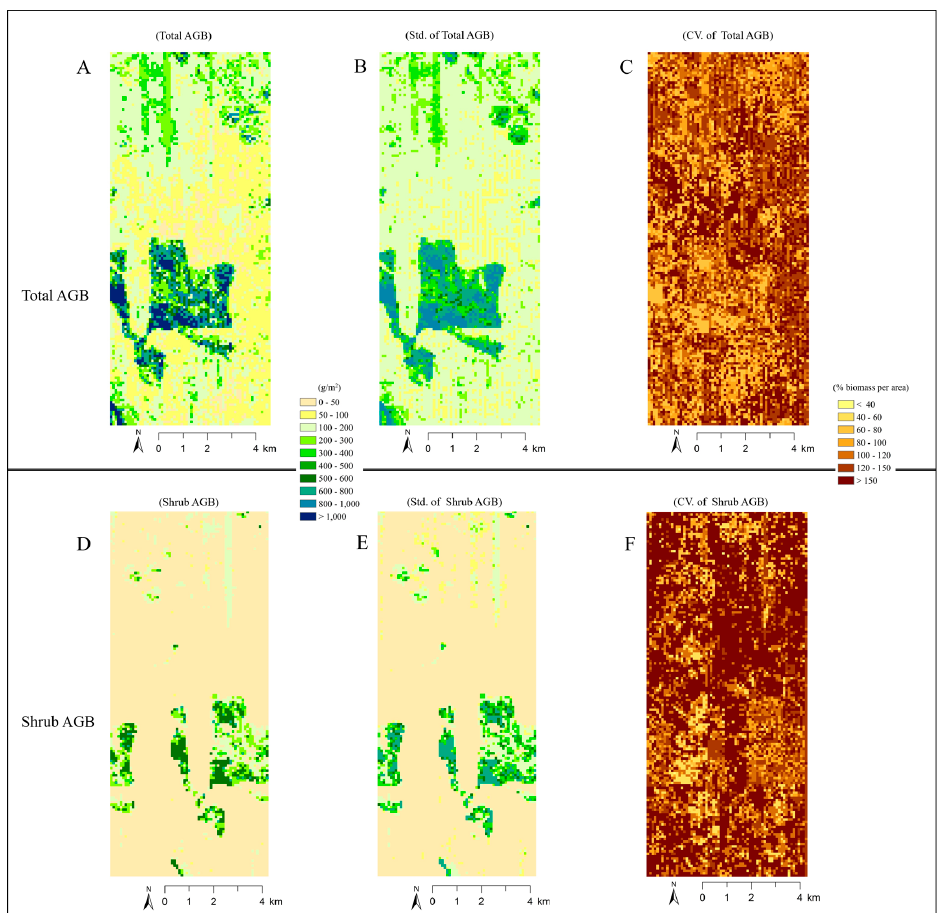
Figure 6. Imputed total AGB ( A ), standard deviation of the imputed total AGB ( B ) and coefficient of variation (CV) of the imputed total AGB ( C ) and imputed shrub AGB ( D ), standard deviation of the imputed shrub AGB ( E ) and coefficient of variation (CV) of the imputed shrub AGB ( F ), across the coverage of the 2013 Lidar.